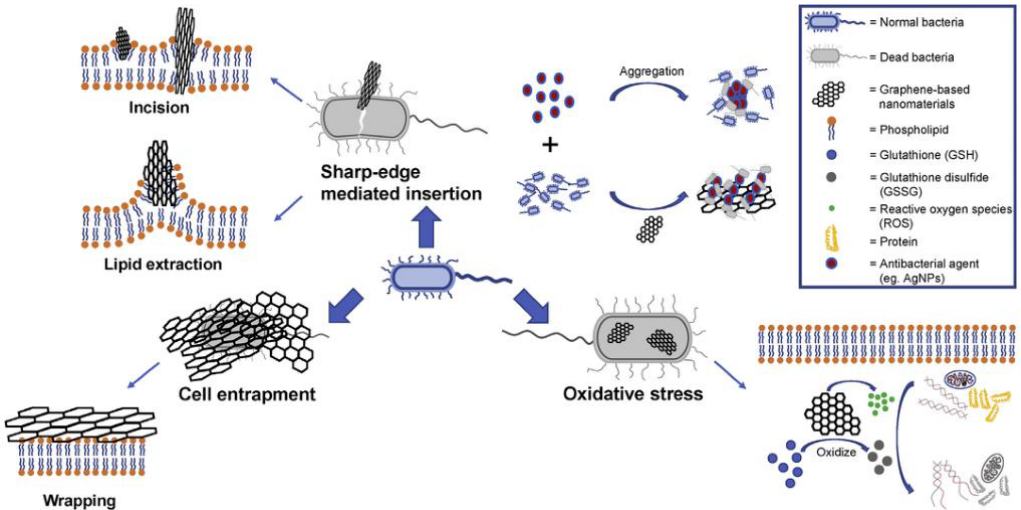
Figure 5. Schematic diagram of the antibacterial mechanism of graphene-based nanomaterials, including sharp edge cutting effect, oxidative stress and cell trapping. (Printed image with permission from Ref. [91], copyright 2019, Elsevier Ltd.).